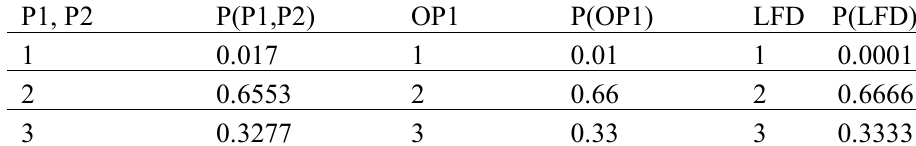
Table 8. Probabilities for events with three states